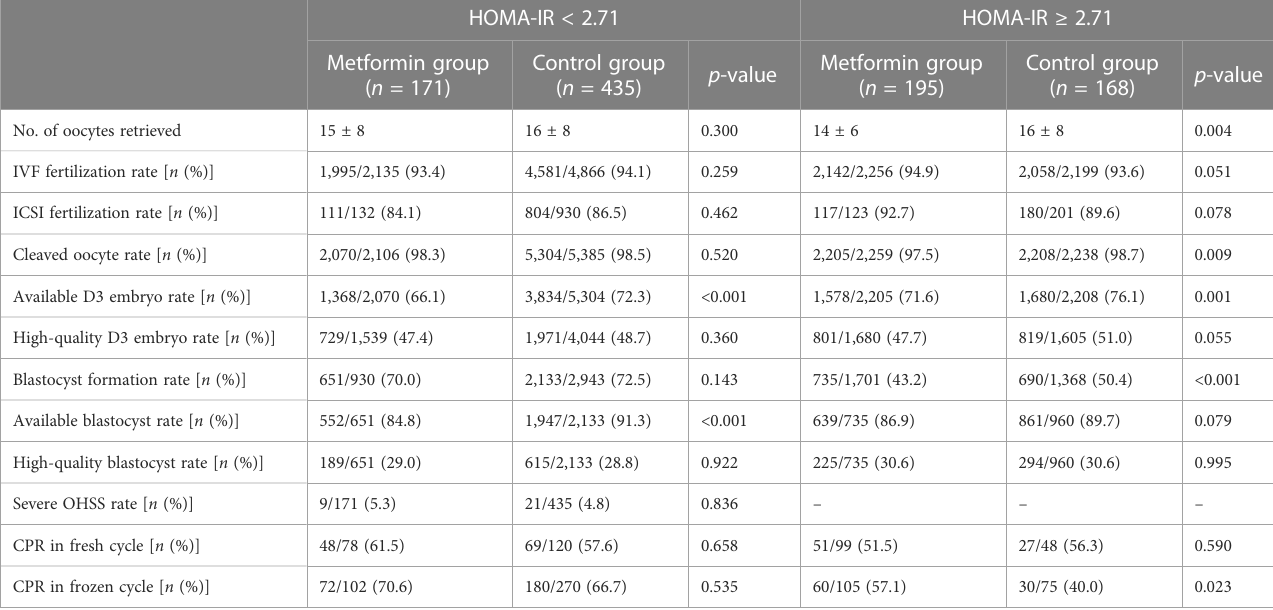
TABLE 3 COS outcomes and clinical pregnancy outcomes between the metformin group and the control group in PCOS patients of different HOMA-IR